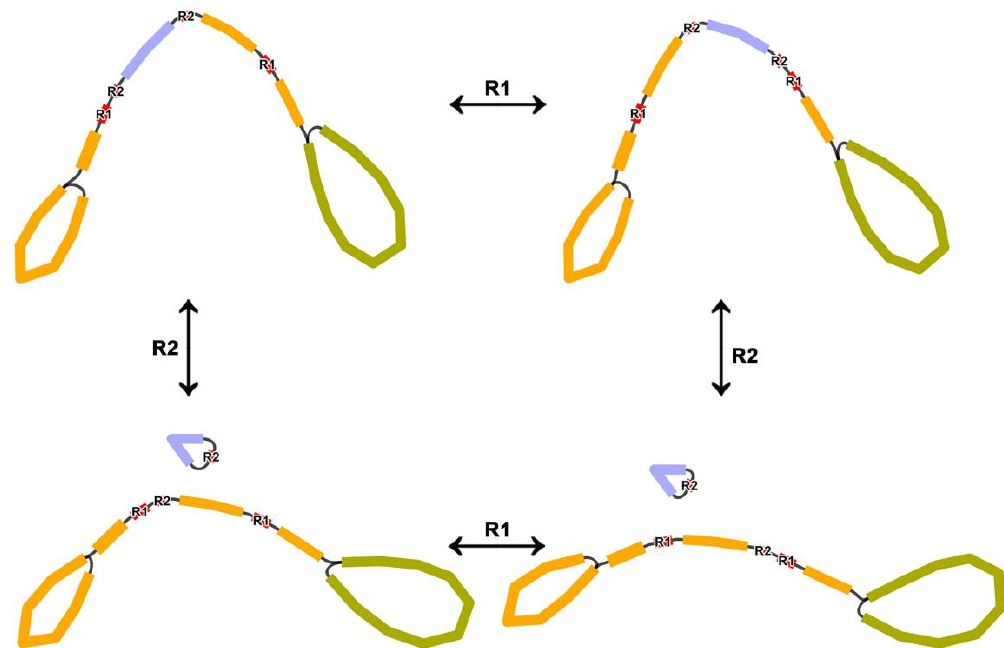
Figure 5. Two pairs of long repeated sequences are involved in mediating Q. acutissima mitogenome reorganization. The orange node represents molecule 1, the yellow–green contig represents molecule 2, and the blue node represents molecule 3.